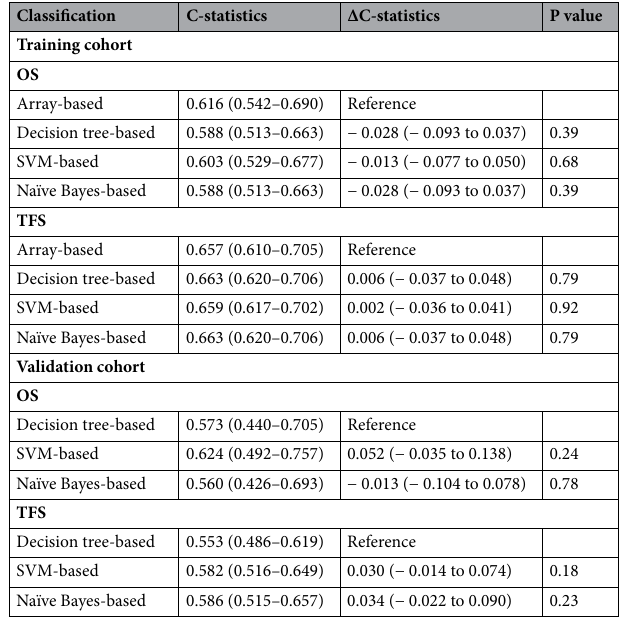
Table 3. Comparison of C-statistics in the models. C-statistics represent Harrel’s C concordance statistics. OS overall survival, TFS transplantation-free